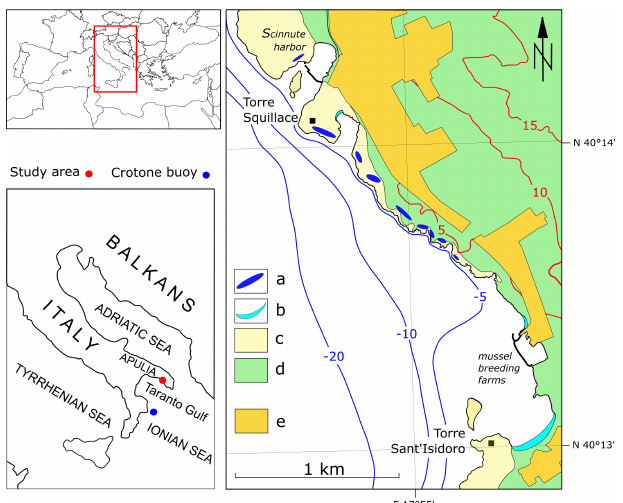
Figure 1. Geological map of the study area (modified from [27]); legend: a, boulder field; b, sandy beach; c, Pleistocene calcarenites; d, Cretaceous limestones; e, urban area; contour lines (red) from the technical map of Lecce Province (1:5000); isobaths (blue) from the nautical chart of Istituto Idrografico della Marina Militare